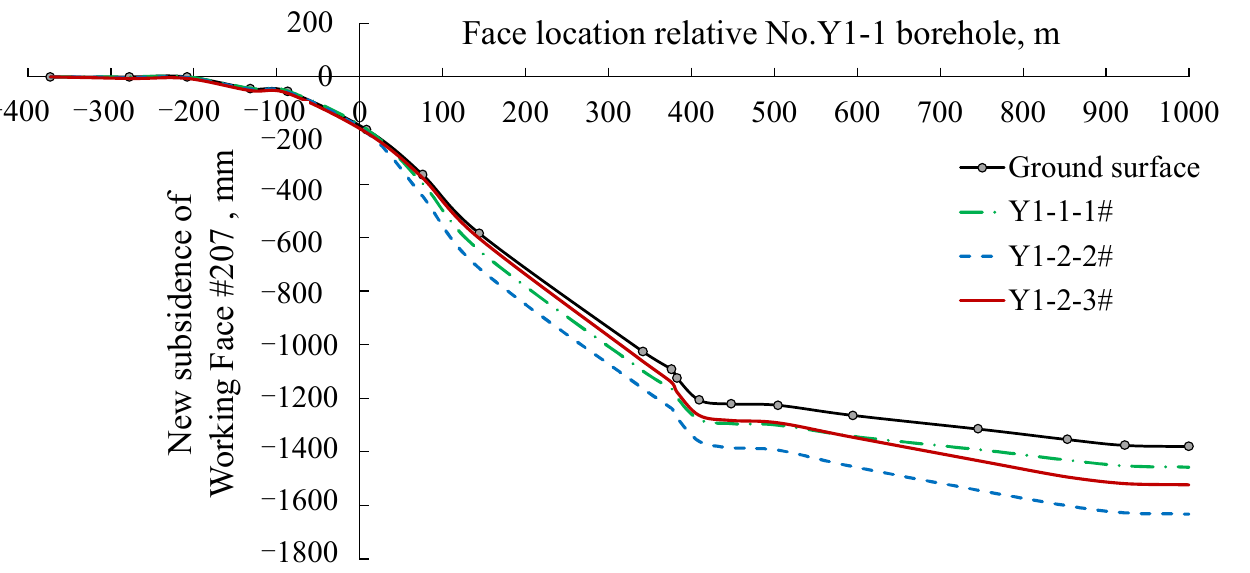
Figure 16 describes how the micro-strain in the fiber optic lines in Y2 changed with the advancement of Working Face #207. In the legend, a negative value is the distance